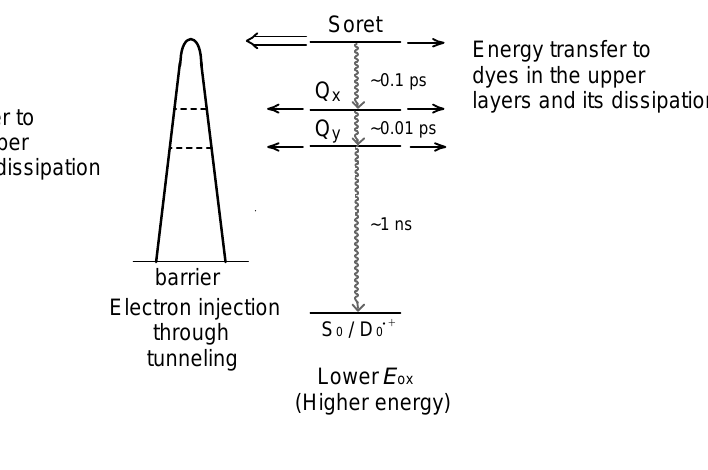
Figure 37. Effects of one-electron oxidation potential on the major electron-injection channels through the tunneling